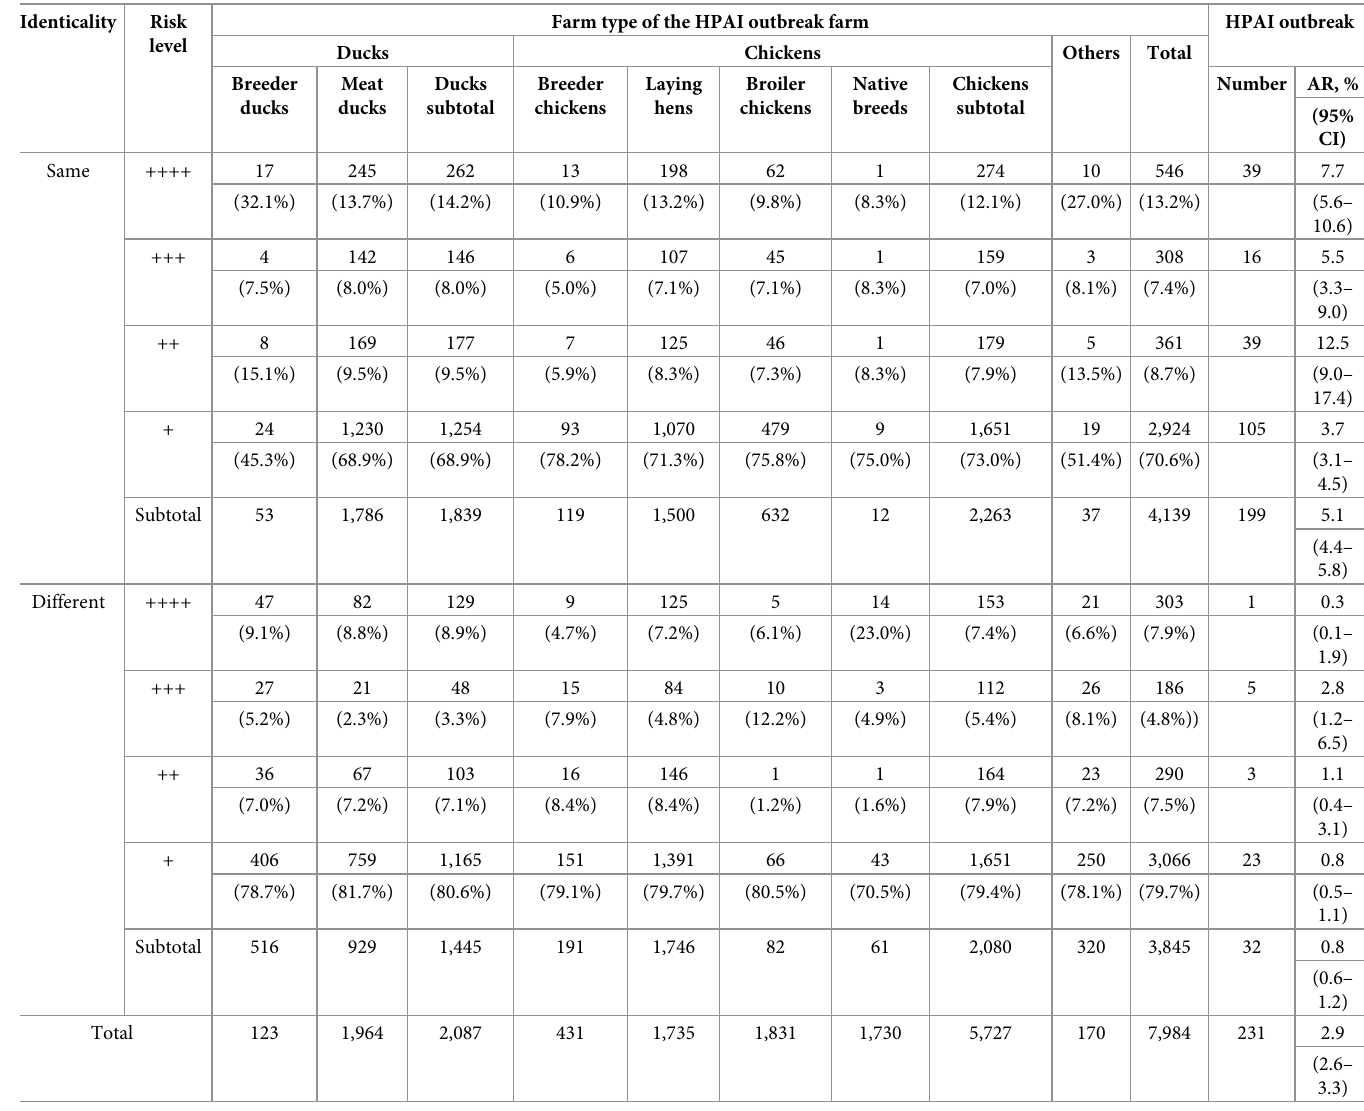
Table 2. Risk level and Attack Rate (AR) according to farm type identicality between outbreak farm and epidemiologically linked farms.